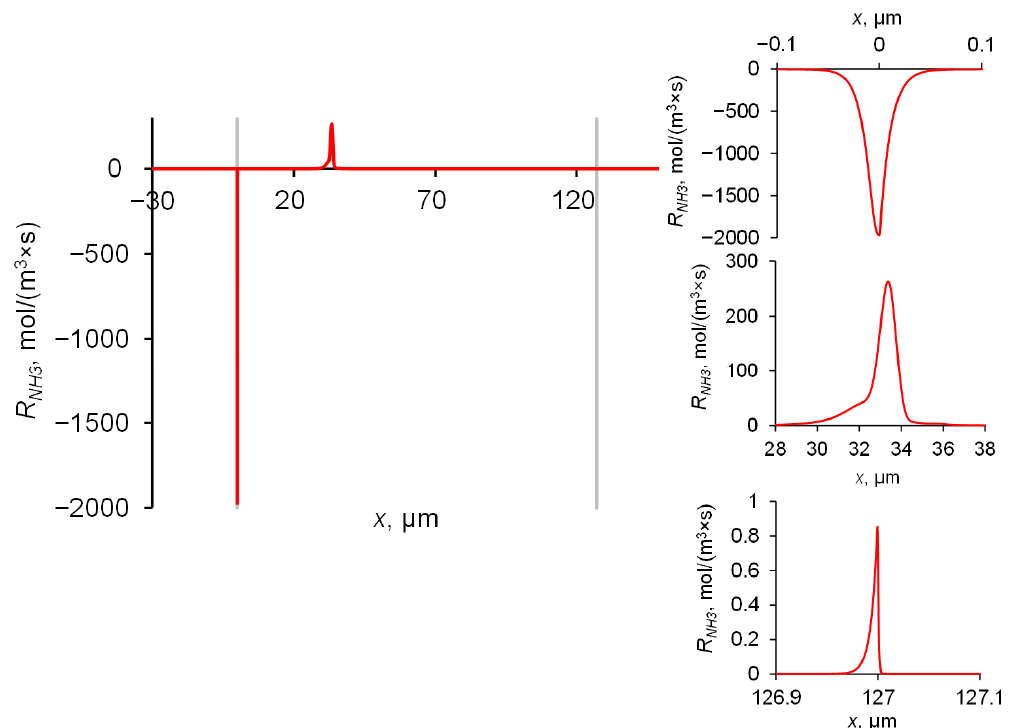
Figure 9. Dependence of the rate of NH 3 molecules’ formations on the coordinate. Magnifications of three reaction zones are presented separately in appropriate scales. Simulation for an AMX membrane and 1 M NH 4 Cl feed solution with the input parameters shown in Table 1.